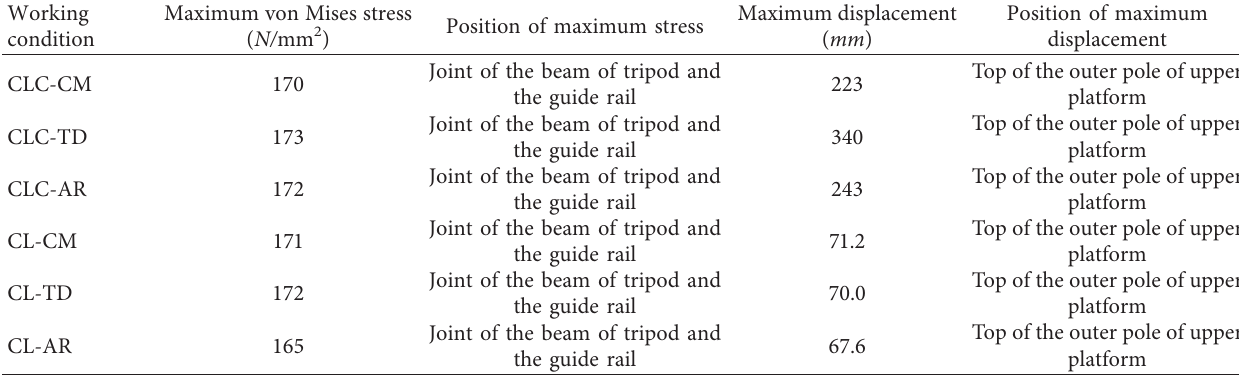
Table 9: Structure peak response of climbing formwork under the climbing condition.